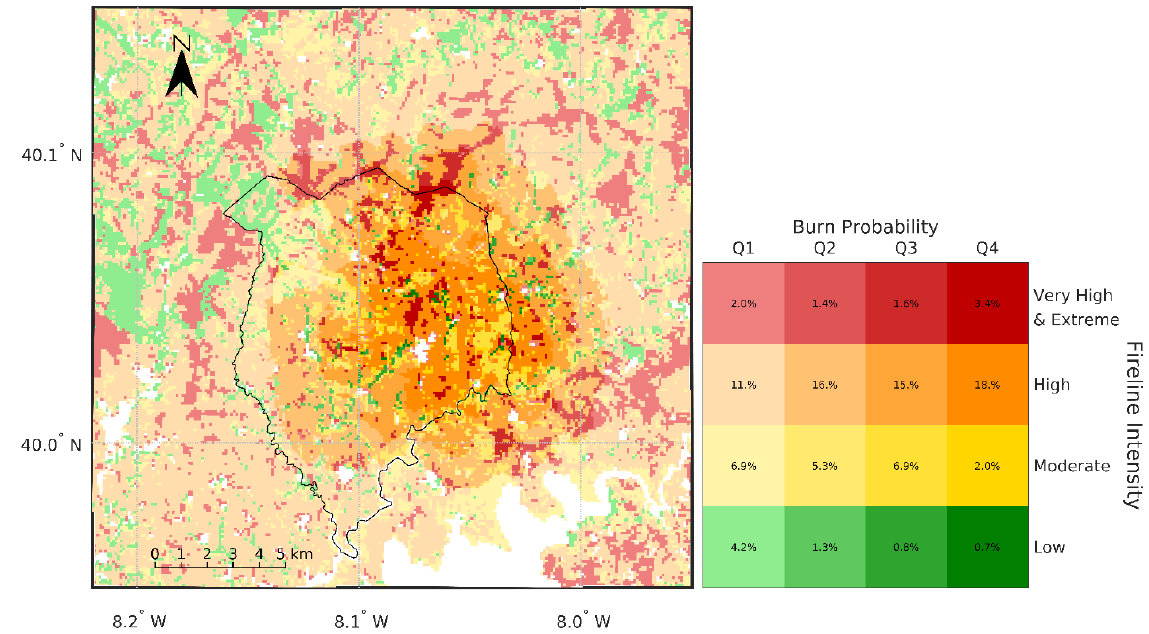
Figure 6. Combination of simulated burn probability and fireline intensity in the Alvares parish and close surroundings. Q1, Q2, Q3 and Q4 are the quartiles of burn probability.